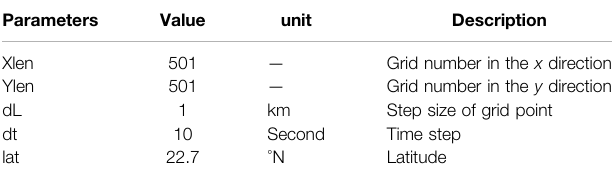
TABLE 1 | Main parameters in barotropic